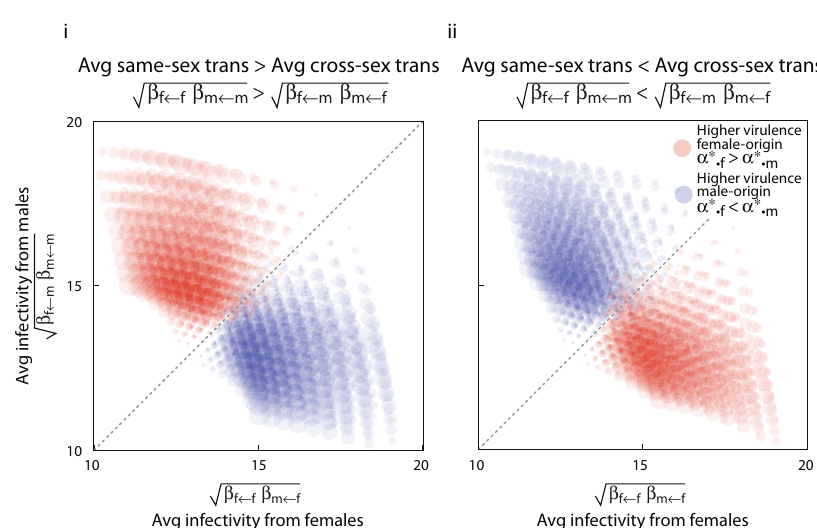
Fig. 4 Evolution of origin-speci fi c virulence with different infectivity and susceptibility between the sexes. On each sub-panel, the difference between evolutionarily stable virulence of female- and male-acquired infections are plotted as circles whose area scales with the extent of the difference. Circles are q ffiffiffiffiffiffiffiffiffiffiffiffiffiffiffiffiffiffiffi β β , and average infectivity of males, de fi ned as centred according to the average infectivity of females, de fi ned as m f f f ffiffiffiffiffiffiffiffiffiffiffiffiffiffiffiffiffiffiffiffiffi q β β average transmissibility between individuals of the same sex, de fi ned as , is higher than the average transmissibility between individuals of the f f m m q ffiffiffiffiffiffiffiffiffiffiffiffiffiffiffiffiffiffiffiffiffi β β . In sub-panel ii , the average transmissibility between individuals of the same sex is lower than the average opposite sex, de fi ned as f m m f transmissibility between individuals of the opposite sex. In both sub-panels, the results are based on a one-population model in which there are no sex- speci fi c differences in background mortality, no possibility of recovery, and no difference in the in fl ux of sexes to the population. Parameters (see Supplementary Information Note 1 and Available Code): c-values all 1, m = 35, ρ = 0.5, μ = 0.5, γ = 0, θ i ← j ranged from 0.5 to 1.5 and all combinations were considered (9 4 different